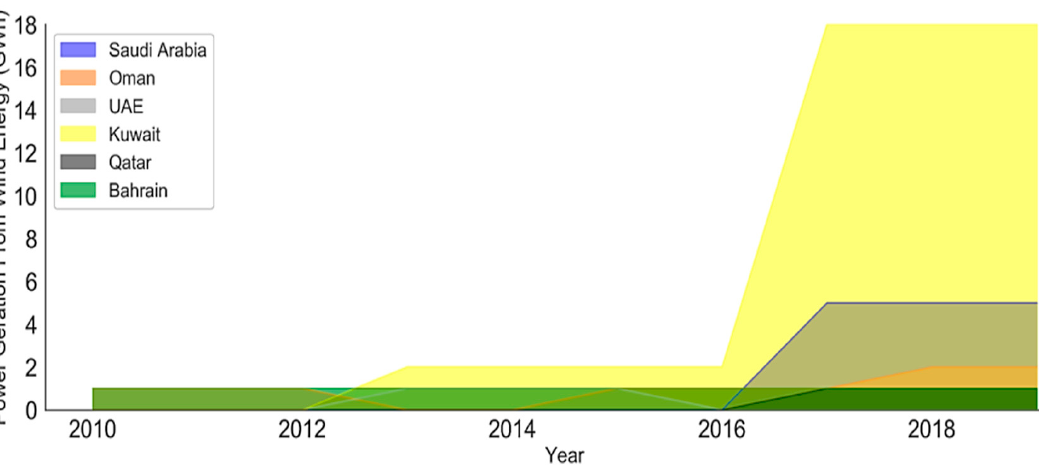
Figure 10. Energy generation from wind energy in GCC region, 2010–2019.